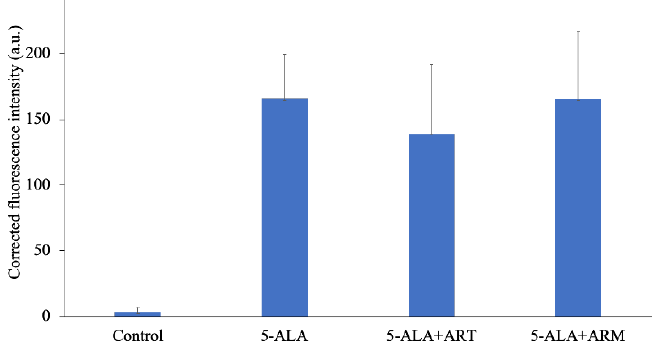
Figure 2. Corrected protoporphyrin IX fluorescence intensity in EMT-6 cells. Cells were incubated with 1 mM 5-aminolevulinic acid (5-ALA), 1 mM 5-ALA, and concentrations of 7.8 μM artesunate (ART) or artemether (ARM) for 4 h. Results are presented as means ± standard deviations ( n = 5).